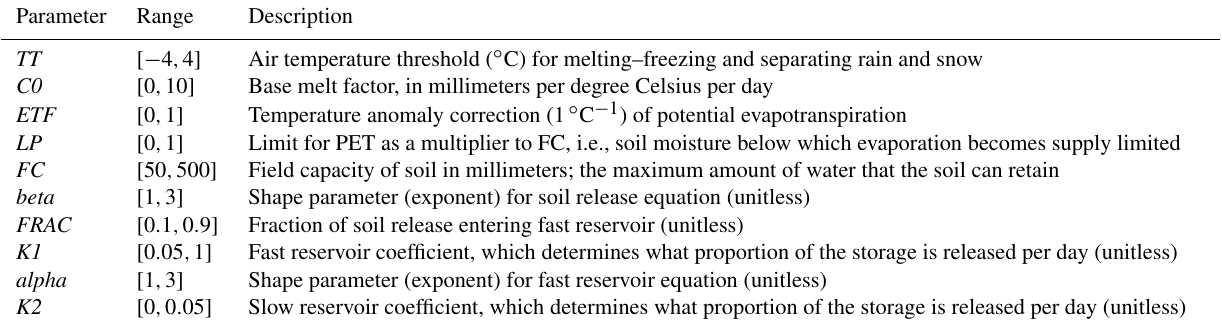
Table 1. HBV-SASK model parameters and their feasible ranges used in this study. For information on the full parameter set, refer to Razavi et al. (2019).